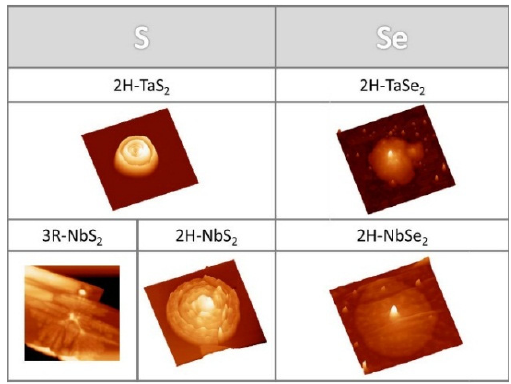
Figure 7. Table for summarizing the oxide growth formations through dynamic-tip LON onto the different exfoliates layers of the five types of TMCs studied: 2H-TaS 2 , 2H-TaSe 2 , 2H-NbSe 2 , 2H-NbS 2 , and 3R-NbS 2.